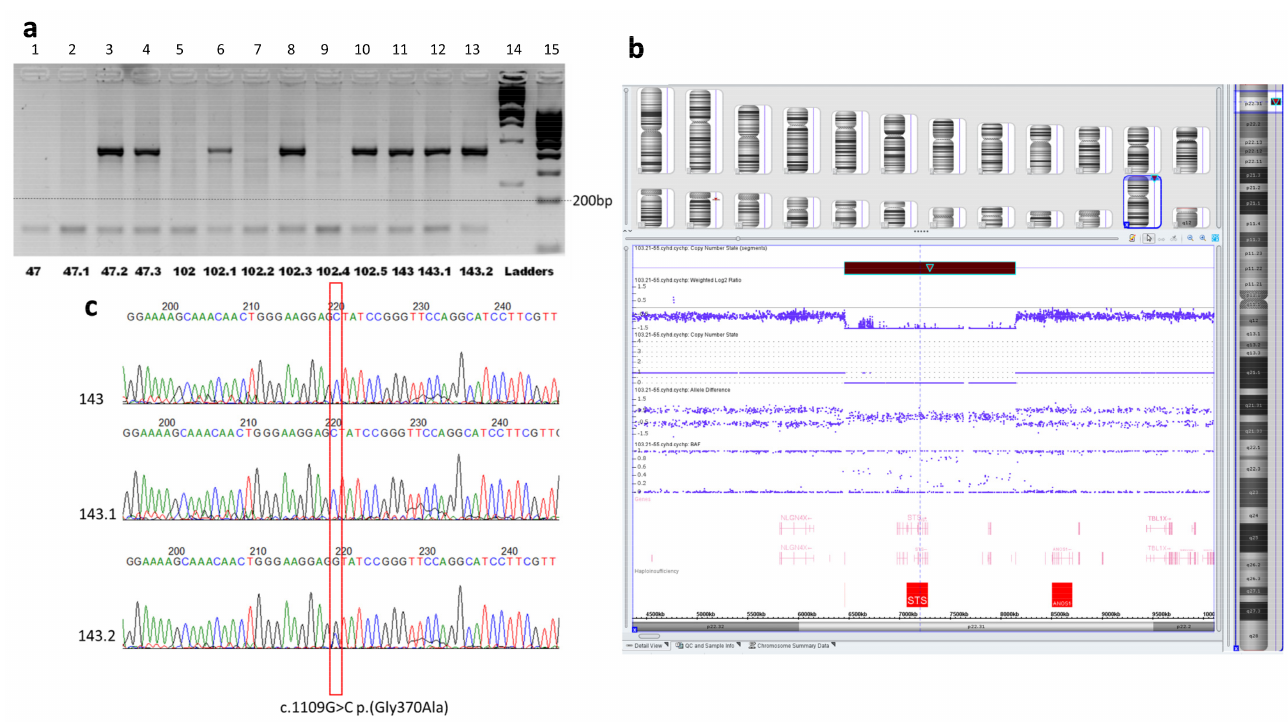
Figure 4. Molecular genetic analysis of the families. ( a ) Photo of the agarose gel electrophoresis of PCR products, two DNA fragments, from the deletion region (sequence of exon 7 of the STS gene, a fragment of 421 bp in size) and control fragment of the constitutive sequence (exon 4 of the PAX6 gene, a fragment of 150 bp in size). The internal fragment from the deletion (the STS gene exon 7) was absent in patients with XLI, ## 47, 47.1, 102, 102.2, and 102.4 (lanes 1, 2, 5, 7, 9). The two fragments one can see in lanes 3, 4, 6, 8, and 10 corresponding to healthy females from pedigrees #47 and #102, as well in the lanes 11, 12, and 13 corresponding to the members of family 143 without deletion. M12,1Kb DNA marker and M34, 100 bp DNA marker (SibEnzyme ® , Moscow, Russia) were used as ladders (lanes 14 and 15). ( b ) CMA results for patient #102. The view of Chromosome Analysis Suite Software of CMA results focused on the Xp22.31 region demonstrating hemizygous deletion affected the entire STS gene with the adjacent sequences. ( c ) Results of Sanger sequencing of the STS gene exon 8 in family #143. Electropherograms demonstrate the variant NM_000351.7:c.1109G>C p.(Gly370Ala) in the hemizygous state in two male patients ## 143 and 143.1, and in heterozygous state in their healthy mother